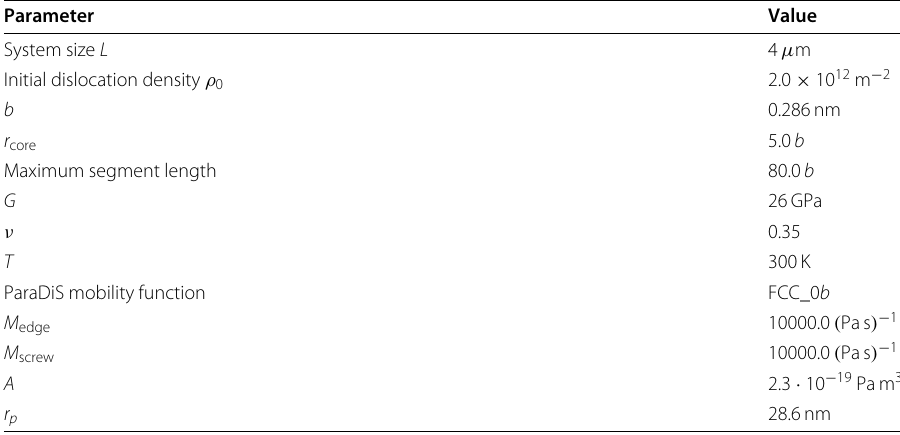
Table 1 Simulation parameters